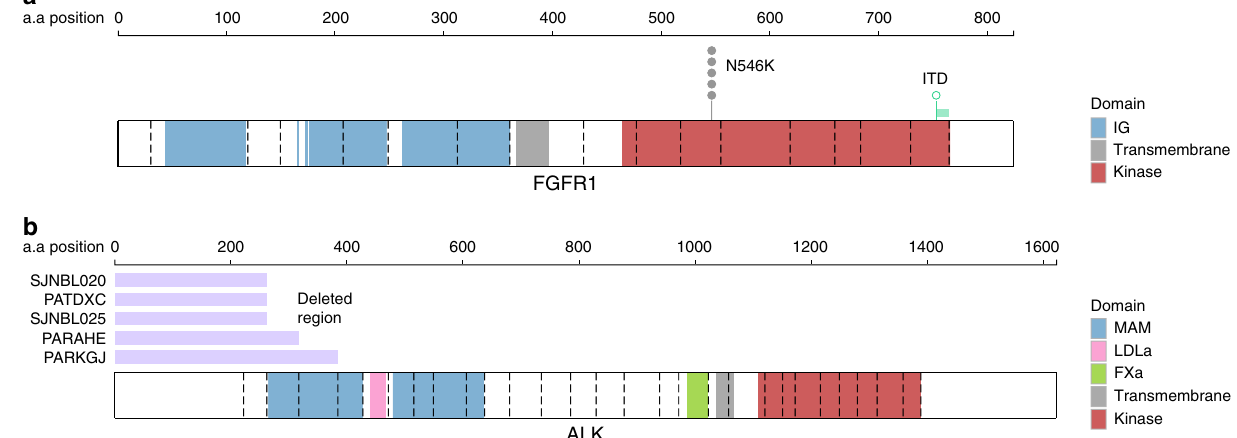
Fig. 2 FGFR1 kinase alterations and ALK N-terminal structural alterations. a Positions of point mutations in FGFR1 in six patients, including 5 SNVs at N546K and an ITD in the kinase domain (duplicated region in green). IG indicates the extracellular immunoglobulin-like domain (blue), while the intracellular kinase domain is shown in red. Exon boundaries are indicated by dotted lines. b ALK protein structure with protein domains indicated by color. Dotted lines indicate exon boundaries. The fi ve samples with ALK N-terminal structural alterations are shown, with the lost exons indicated in purple. MAM indicates Meprin A5 and tyrosine phosphatase Mu domain; LDLa indicates low-density lipoprotein receptor domain class A domain; FXa indicates coagulation factor Xa inhibitory site